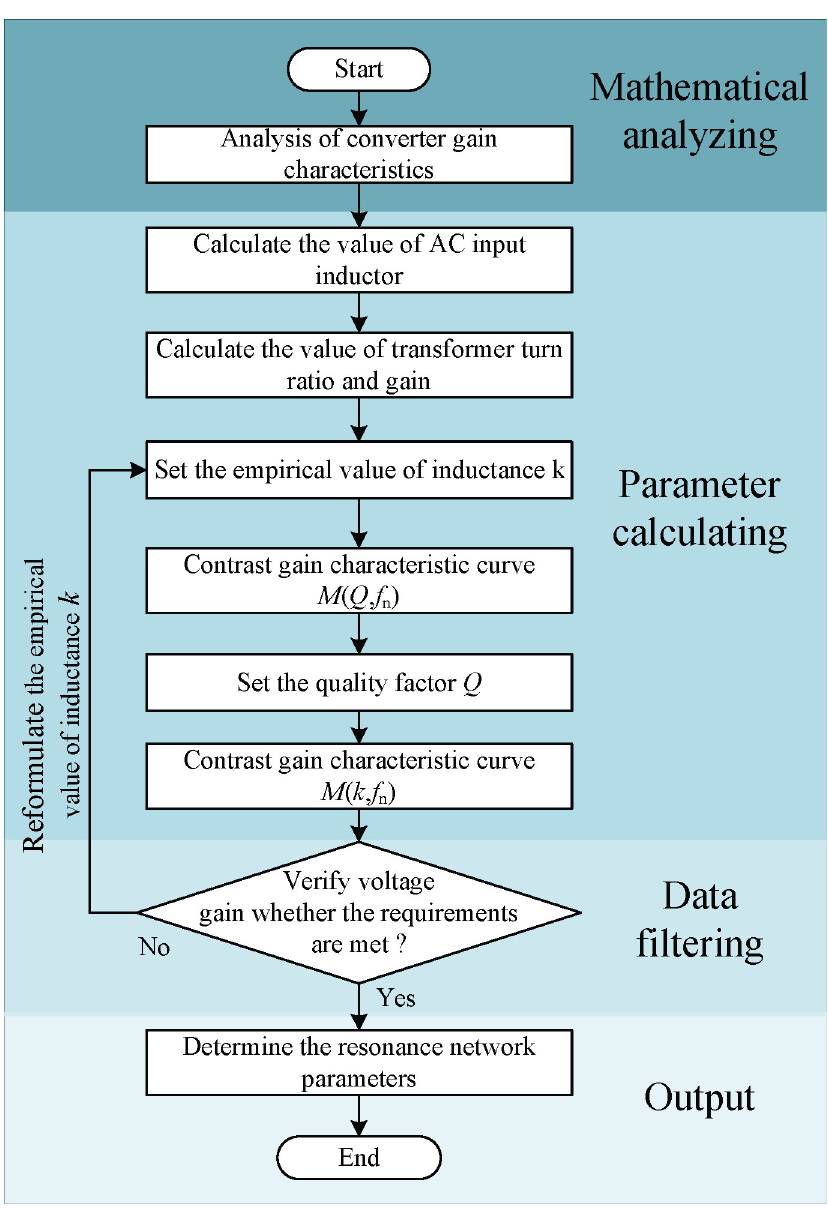
Fig 6. Design process of system